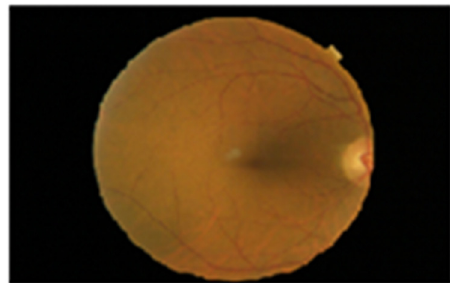
Figure 2: Input image.